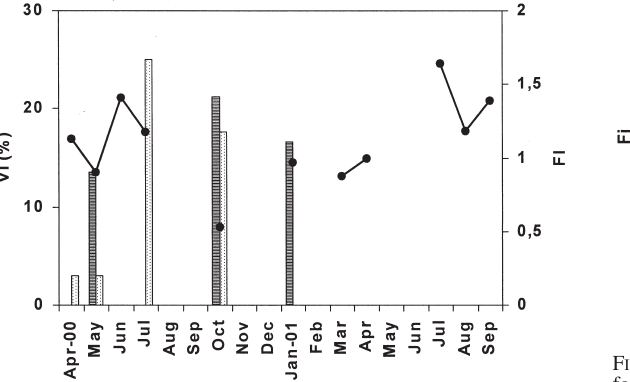
F IG . 7. – Monthly variation of vacuity index ( VI ) males (dark bars), females (light bars), and fullness index ( FI ) (full circles).